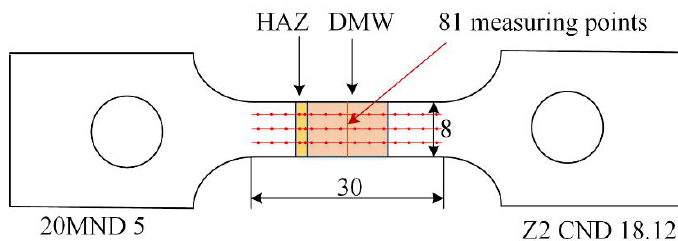
Figure 15. Layout diagram of virtual extensometers. Table 2. Uniaxial tensile testing results of BMs and a DMW joint.